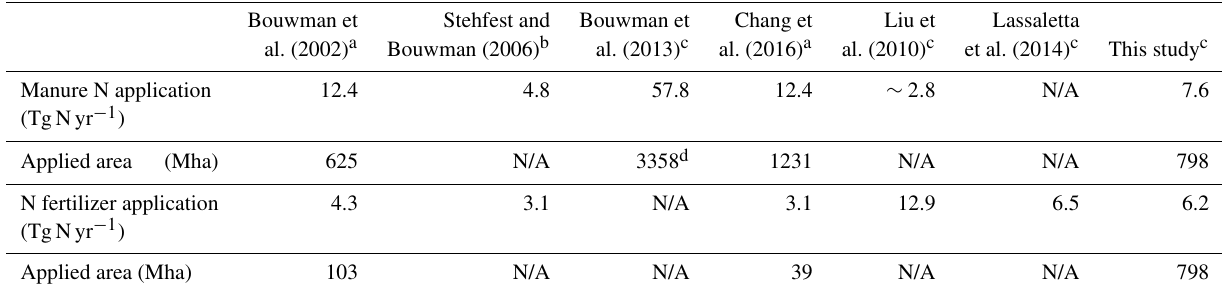
Table 2. Comparison of manure and fertilizer N application amounts between this study and published datasets. N/A: not available. Bouwman et Stehfest and Bouwman et Chang et Liu et Lassaletta Bouwman (2006) b This study